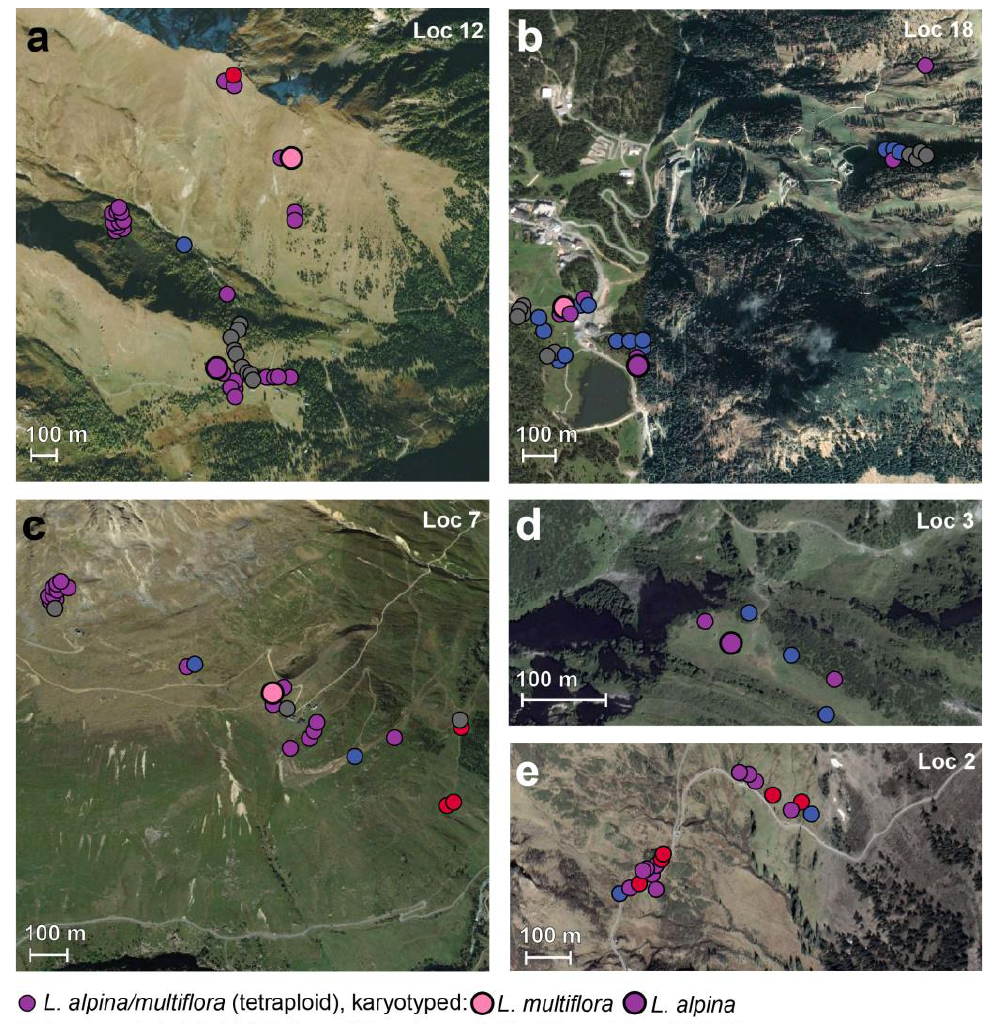
Figure 3. Sampling localities of Luzula alpina/L. multiflora , L. campestris , L. exspectata , L. multiflora and L. sudetica . Sizes of pie charts are proportional to the number of sampled individuals per locality; colors indicate the proportions of the sampled taxa. Locality numbers correspond to Table S1.